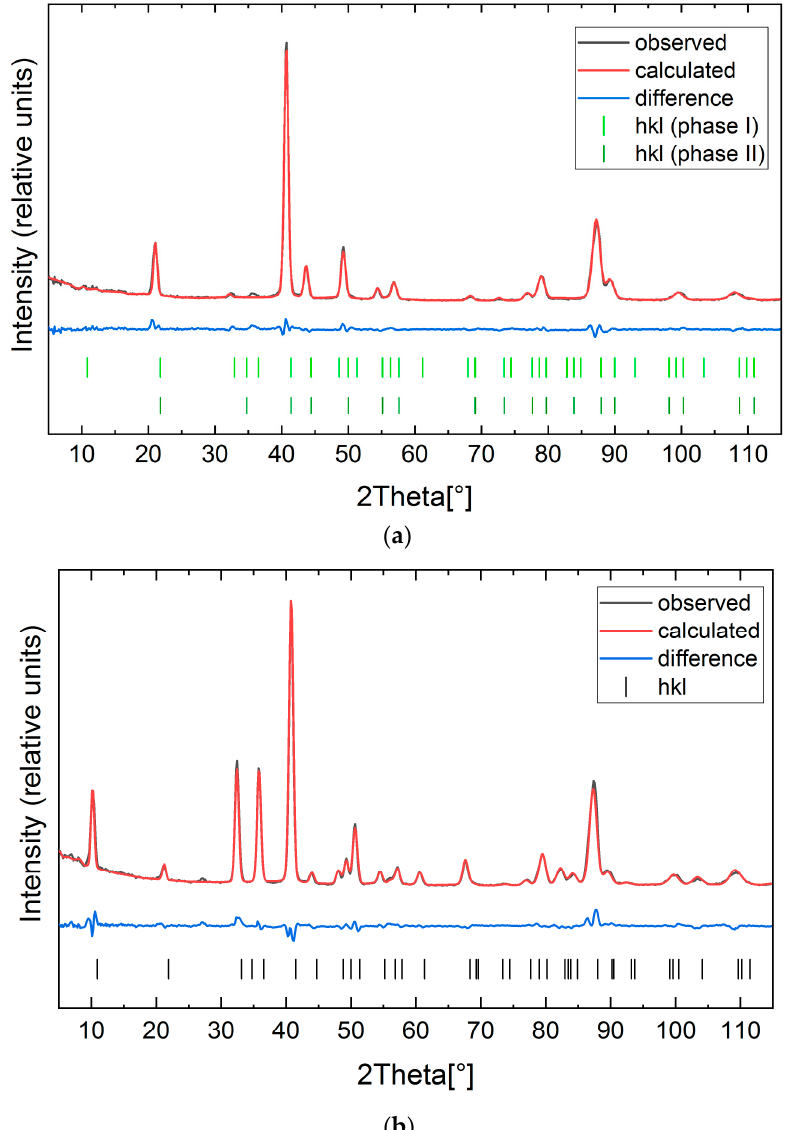
Figure 6. Magnetic refinement of the neutron powder diffractogram of Mn 1.8 Co 0.2 Sb at ( a ) 200 K (Shubnikov groups: P[c]cmn (phase I) and Pmm’n’ (phase II)) and ( b ) 50 K (Shubnikov group: P[c]cmn ). Table 3. Refined magnetic moments μ Mn1/Co1 and μ Mn2 for the different temperatures.